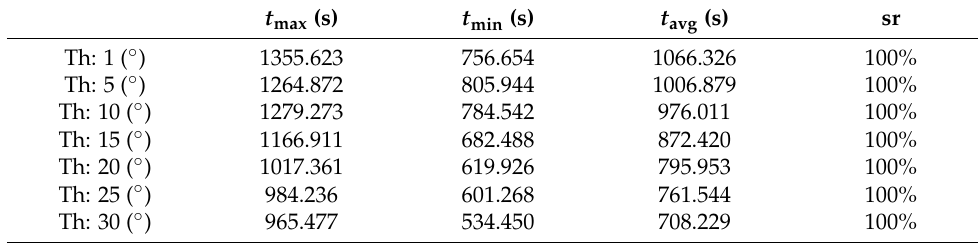
Table 2. Planning results of B-RRT*-LPR.